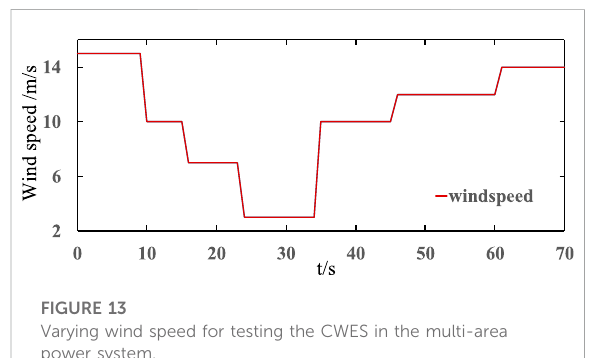
FIGURE 13 Varying wind speed for testing the CWES in the multi-area power system.